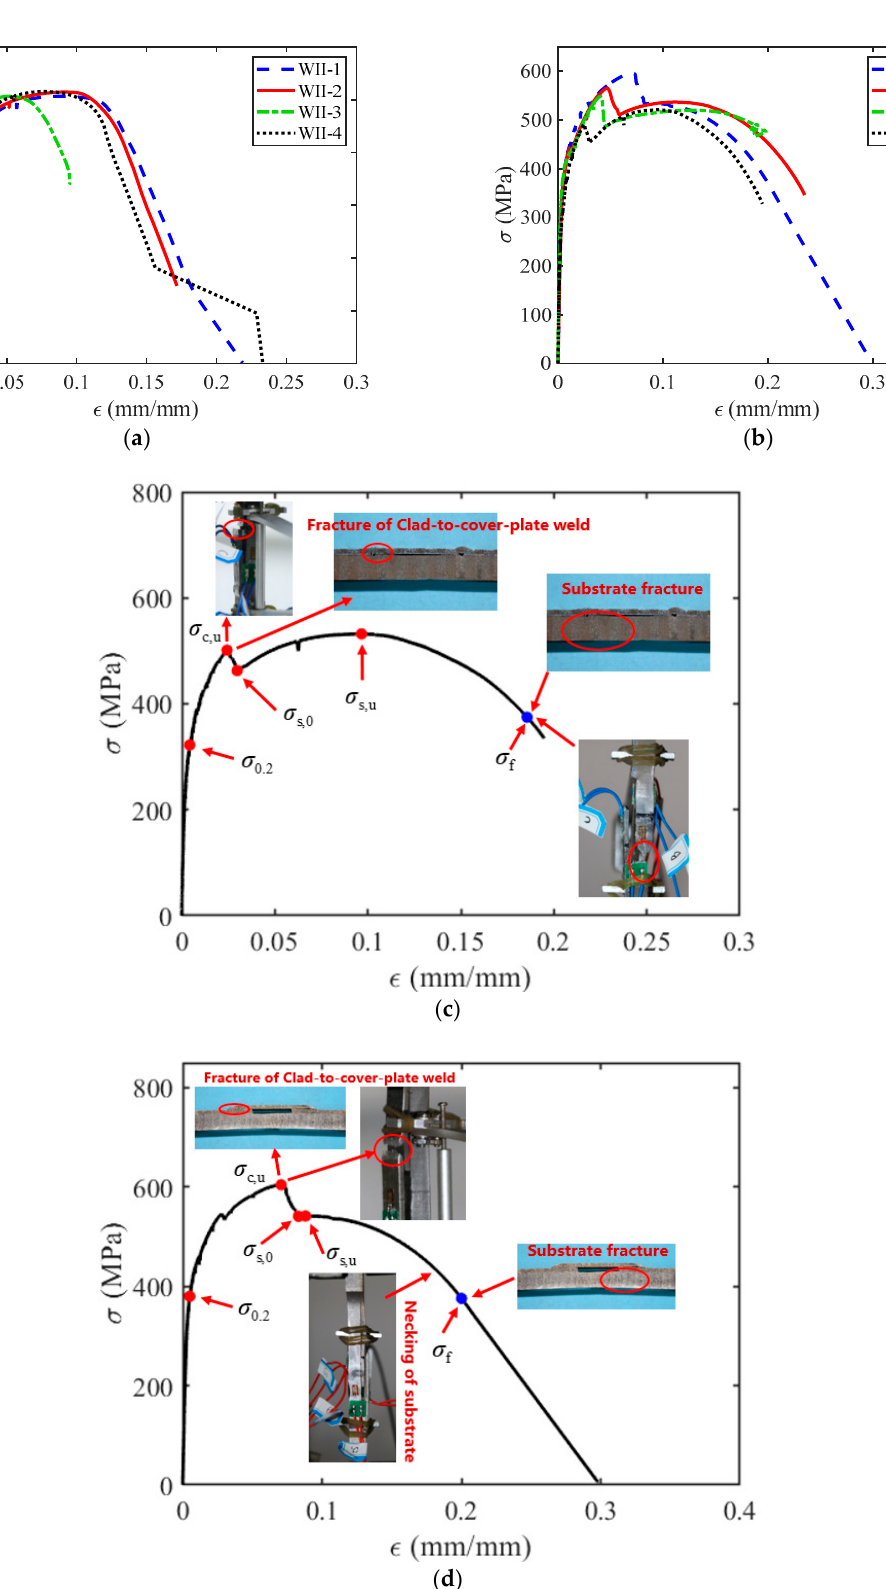
Figure 13. Experimental stress-strain curves of test coupons. ( a ) Test curves of type II welded joint, ( b ) Test curves of type III welded joint, ( c ) Relationship between failure mechanism and stress–strain relations (type II welded joint) and ( d ) Relationship between failure mechanism and stress–strain relations (type III welded